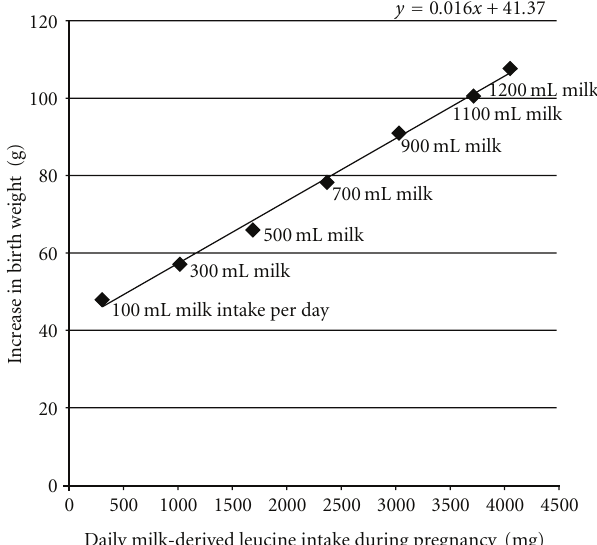
Figure 3: Linear correlation between milk-derived leucine intake of pregnant mothers and increase of the infants’ birth weight. Data obtained from Olsen et al.